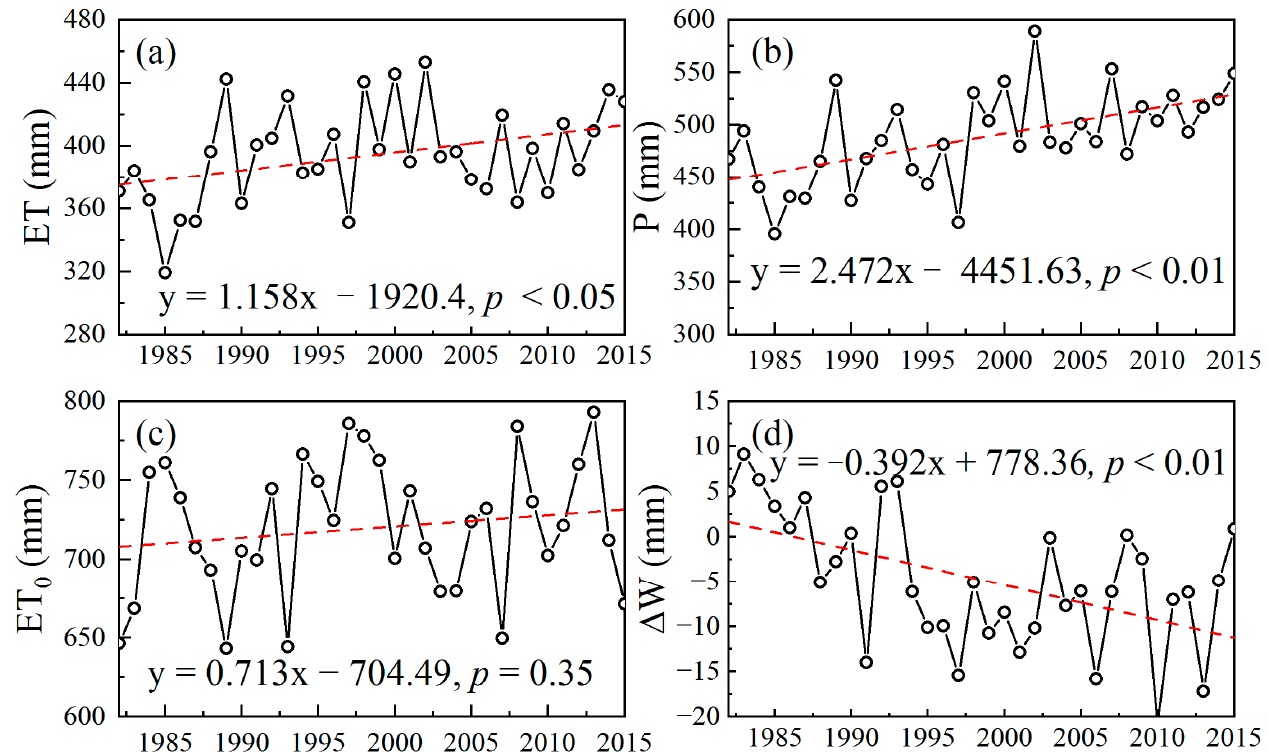
Figure 2. Temporal variations in annual ( a ) ET, ( b ) P, ( c ) ET 0 , and ( d ) ∆ W during 1982–2015.